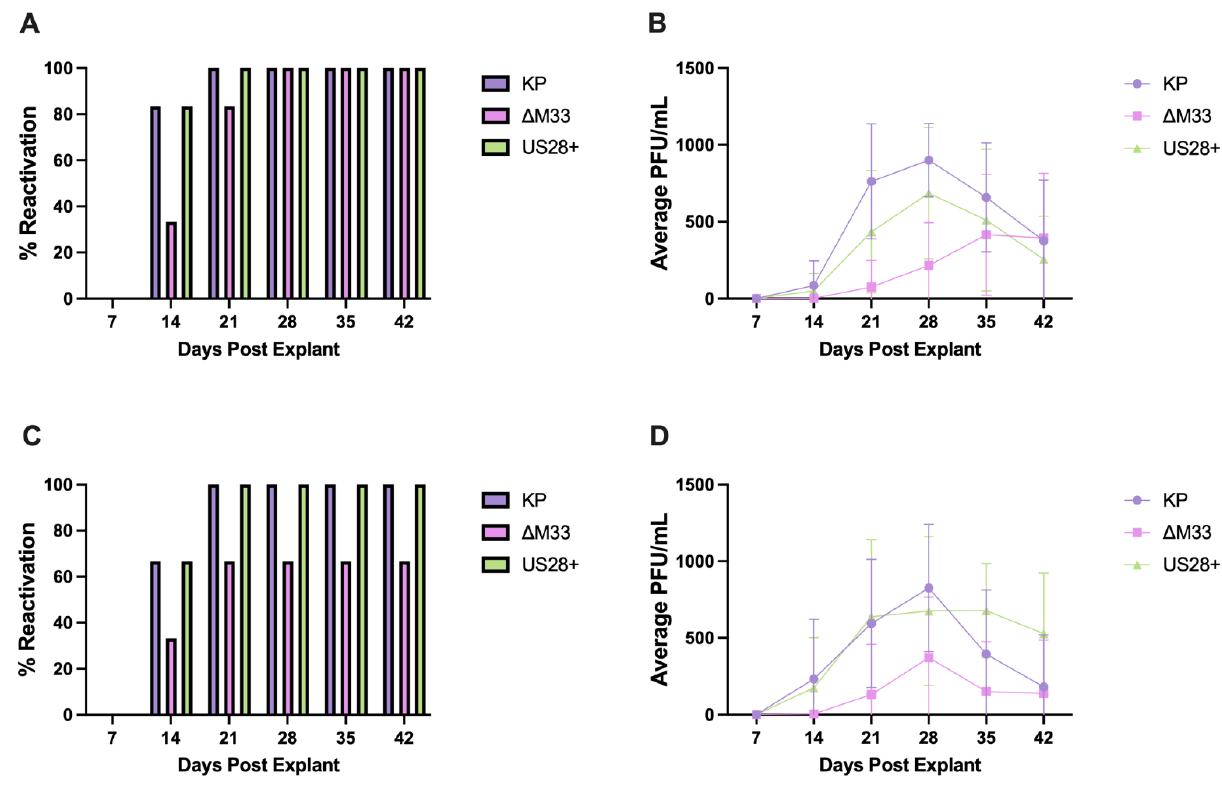
Figure 8. Ex vivo reactivation of MCMV from the heart. Animals were infected with 1x10 6 PFU by i.p. At 70 dpi ( A , B ) and 90 dpi ( C , D ), hearts are cultured ex vivo for 6 weeks to evaluate